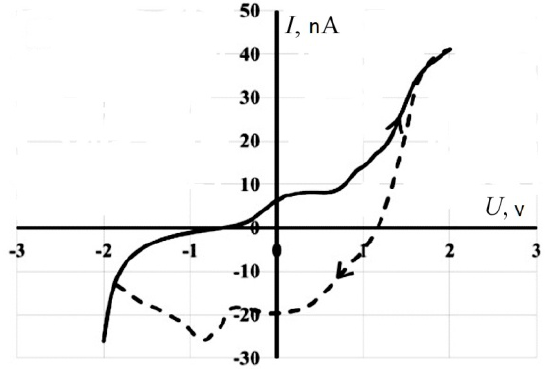
Fig. 6. LTCVCs of DPT-nAu on the surfaces of gold. Fig. 7. LTCVCs of DPT-0 (1) DPT-1 (2) and DPT-nAu (3) on the surfaces of